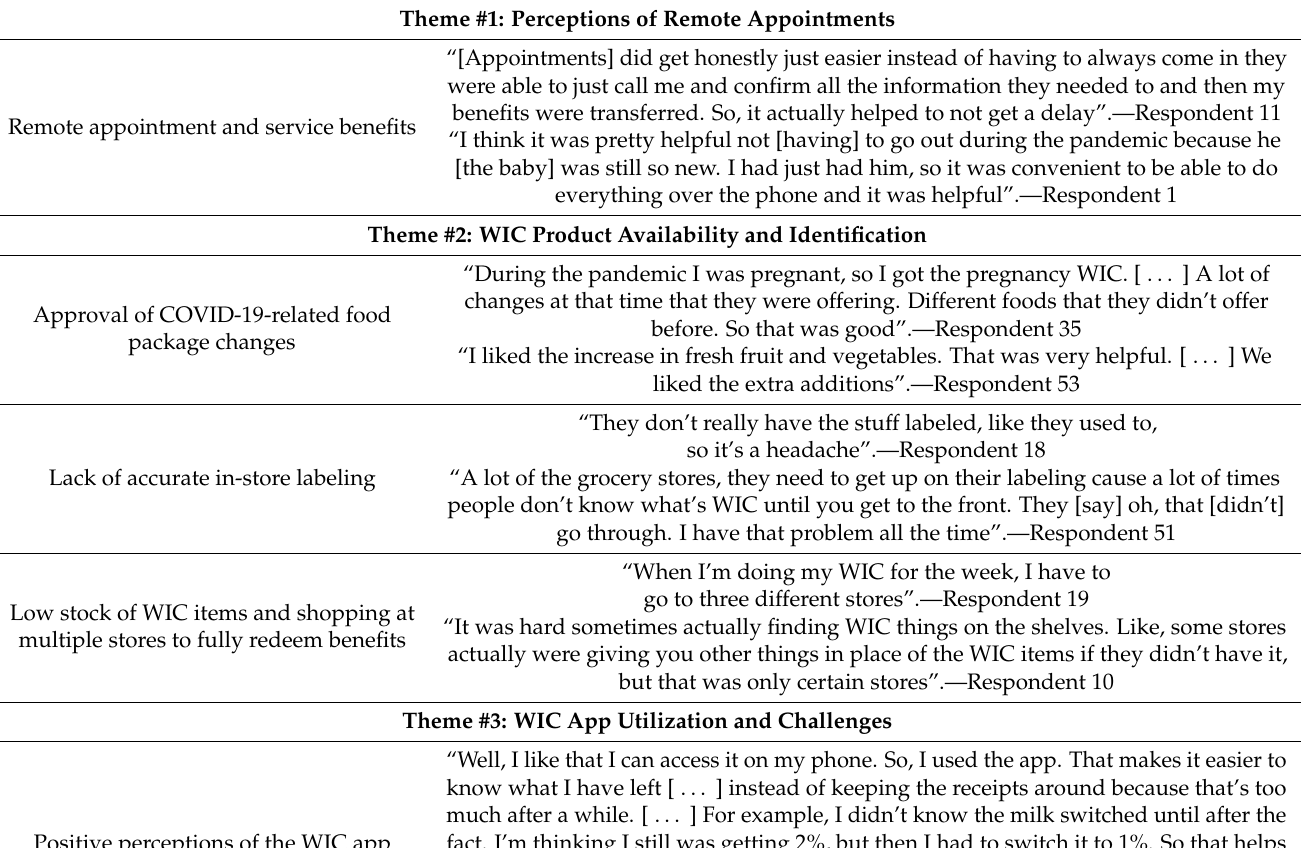
Table 3. Qualitative themes and exemplar